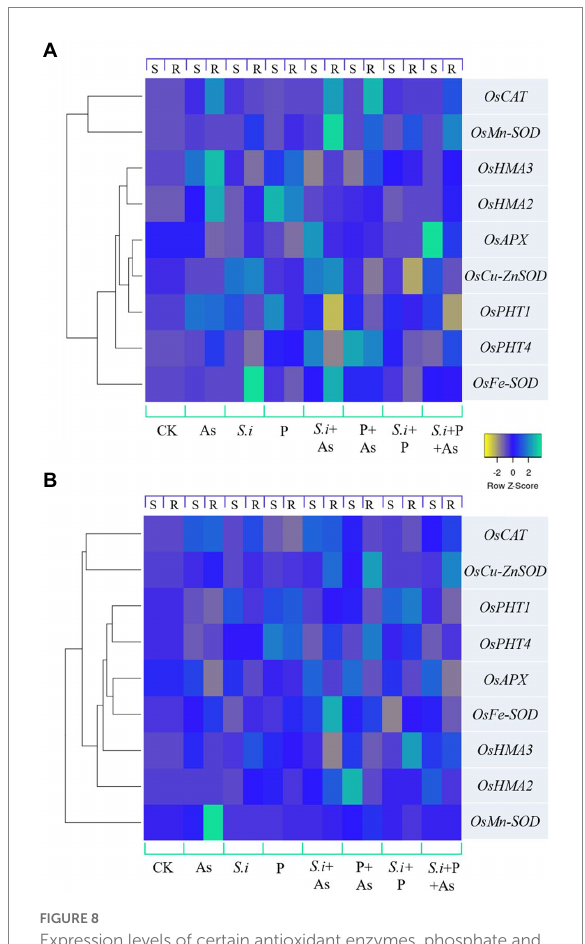
FIGURE 8 Expression levels of certain antioxidant enzymes, phosphate and heavy metal transporter genes under alone and combined Serendipita indica symbiosis and phosphorus application in two rice genotypes displaying different As accumulation tendencies. Color scale shows Z values, where yellow depicts downregulatory and light blue shows upregulatory trend. (A) GD-6 genotype and (B) ZZY-1; S, Shoot; R,